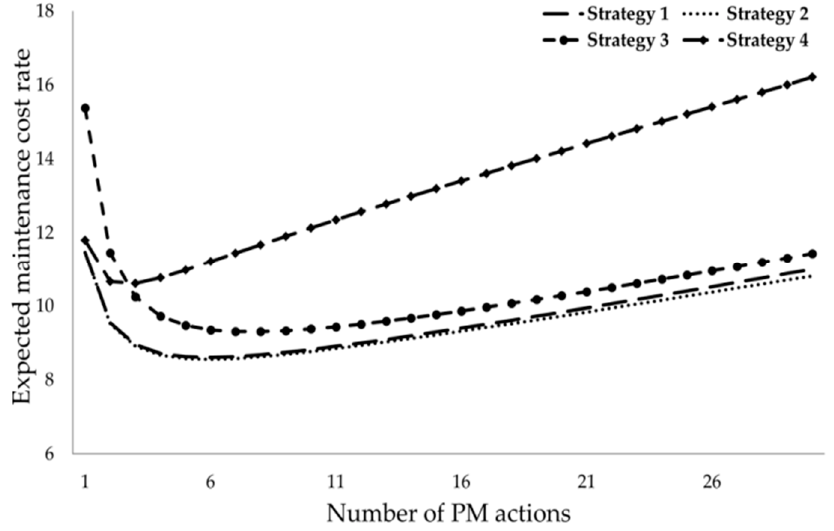
Figure 1. Cost curve under increasing the number of preventive maintenance (PM) activities. Table 5. The optimal solutions and their system performances.